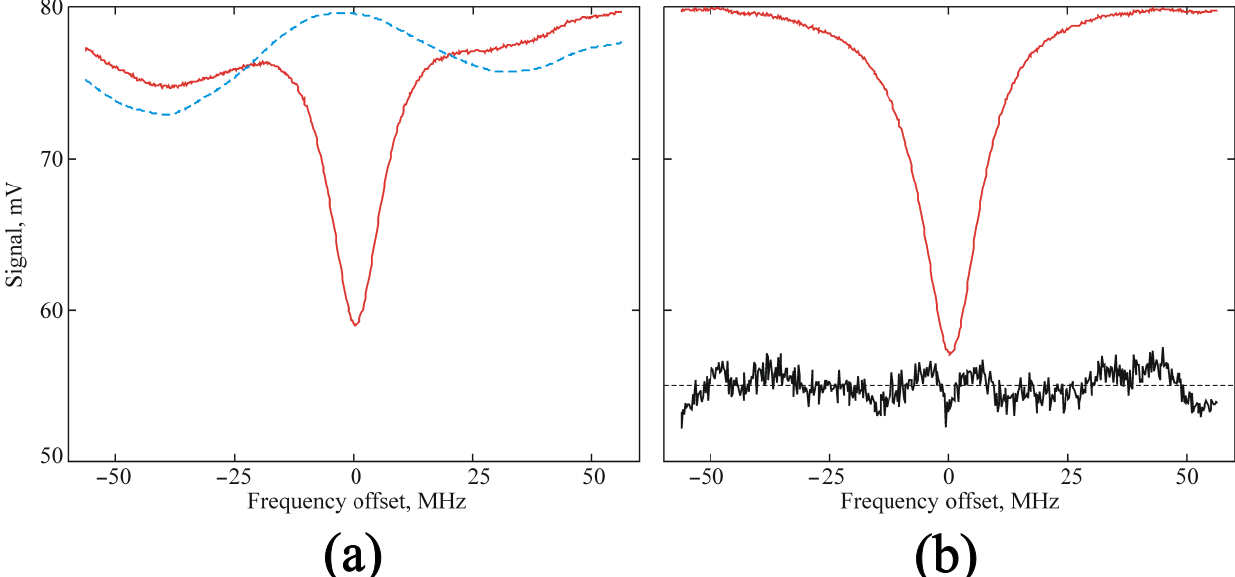
Figure 6. Experimental recording of the H 2 O line near 183 GHz, which was obtained under a pressure of 0.43 Torr: ( a ) the initial recording averaged over 16 triangular scans (solid red line) and the base line (dotted blue line); ( b ) the profile obtained after the subtraction of the variable component of the baseline (solid red line) and the residual “experiment minus model” shifted to 55 mV relative to 0 and multiplied by 10.